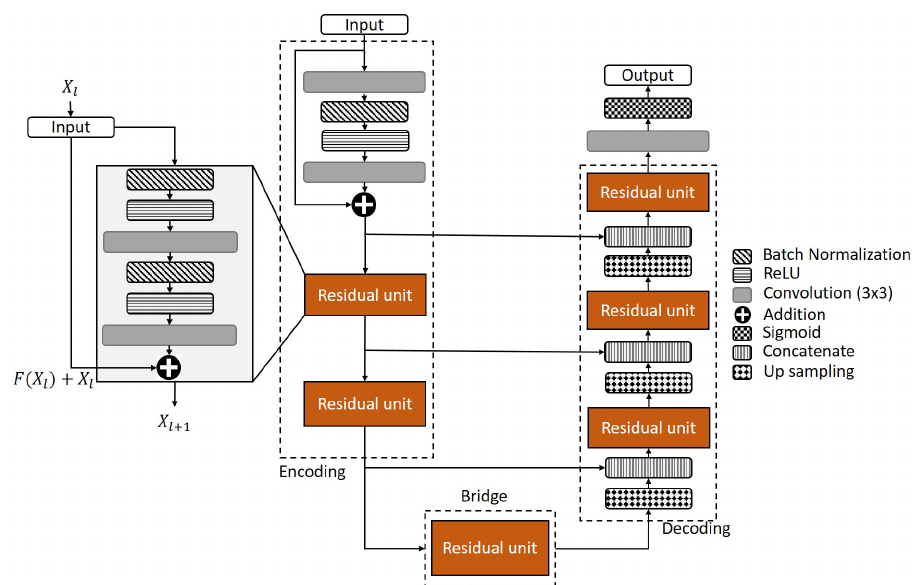
Figure 5. Architecture of Deep Residual U-Net (ResU-Net).